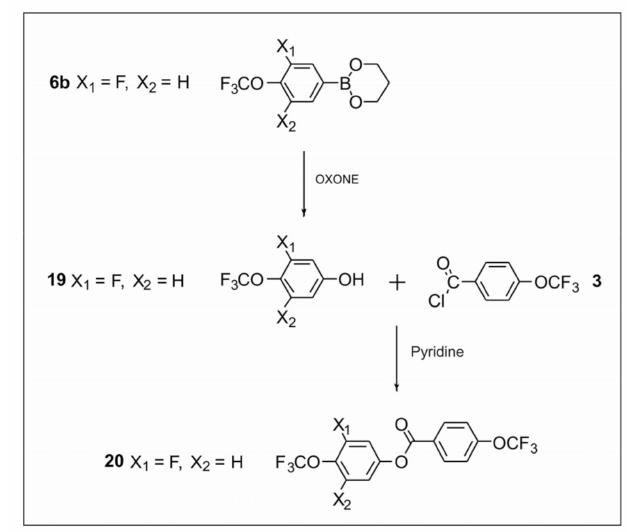
Figure 7. Synthesis of 3-fluoro-4-(trifluoromethoxy)phenyl 4-(trifluoromethoxy) benzoate 20 .